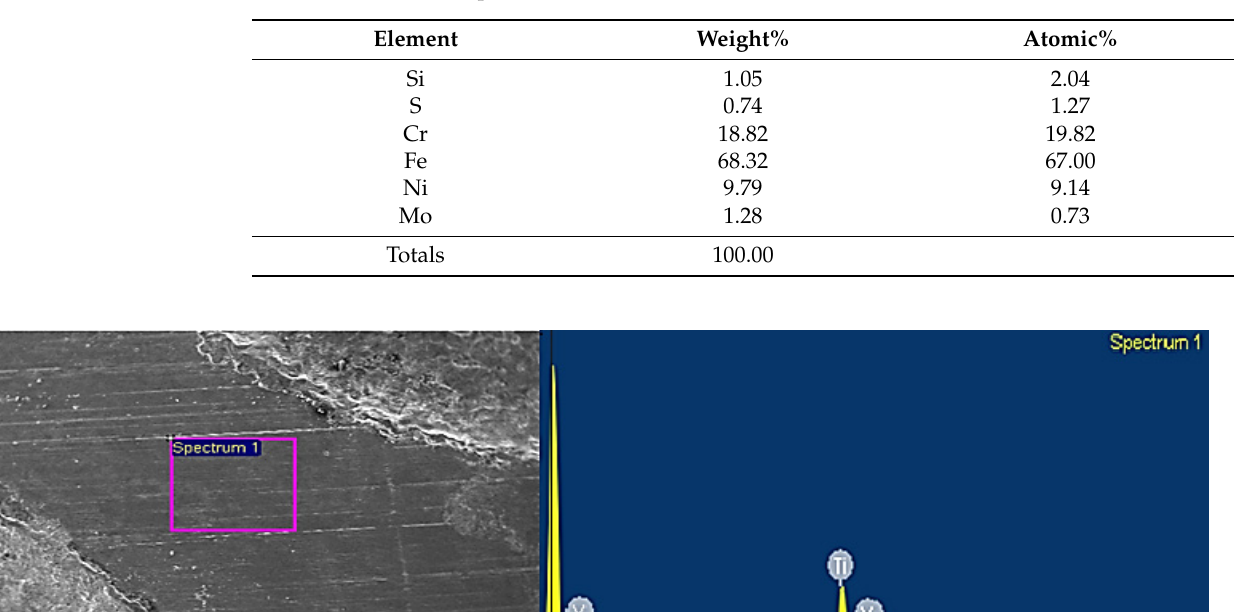
Table 2. Chemical composition of SS316.